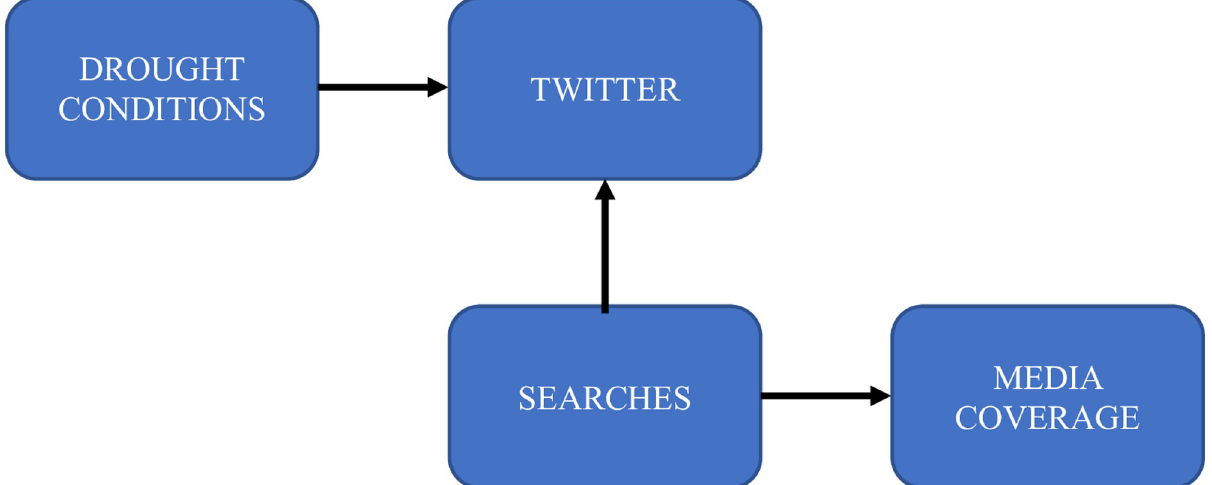
Fig 5. The drought crisis agenda appears to be set by Twitter. Google searches reinforce Twitter activity as well as media coverage, although neither of them are directly responsive to drought conditions.